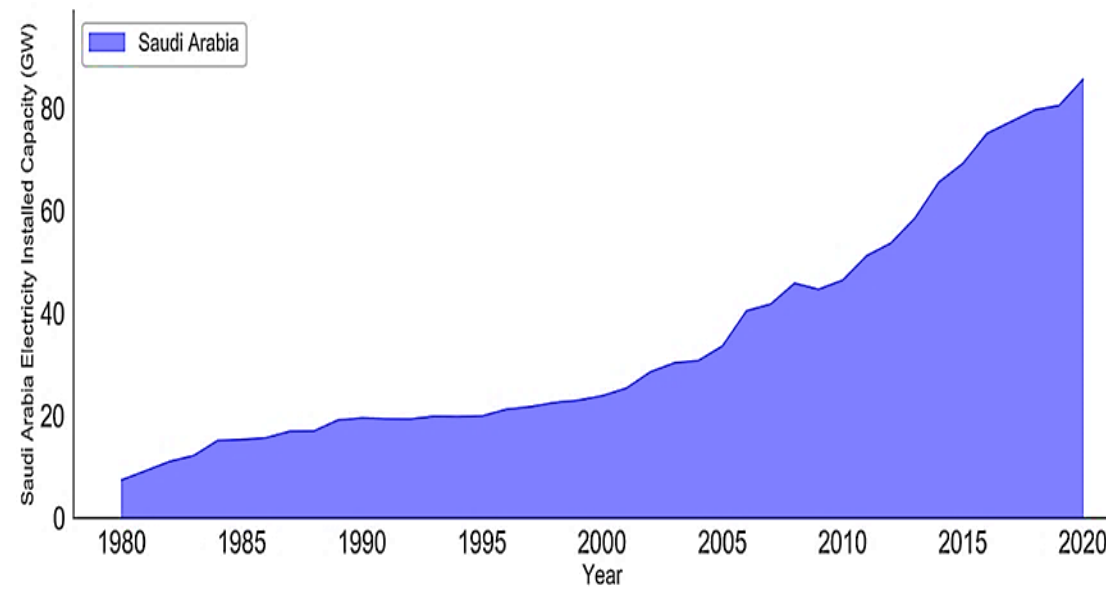
Figure 4. Historical levels of electricity installed capacity in Saudi Arabia.